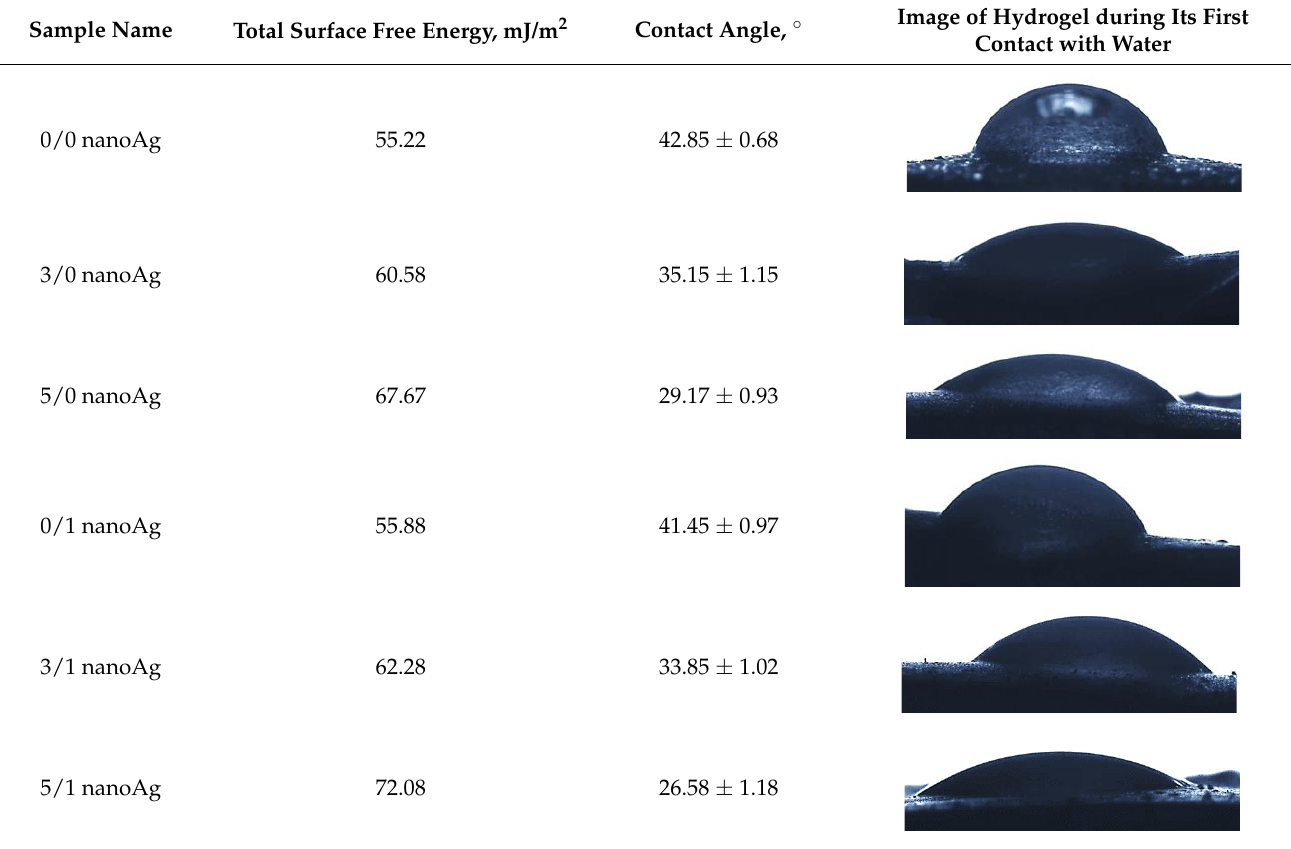
Table 1. Results of hydrogels’ wettability analysis.